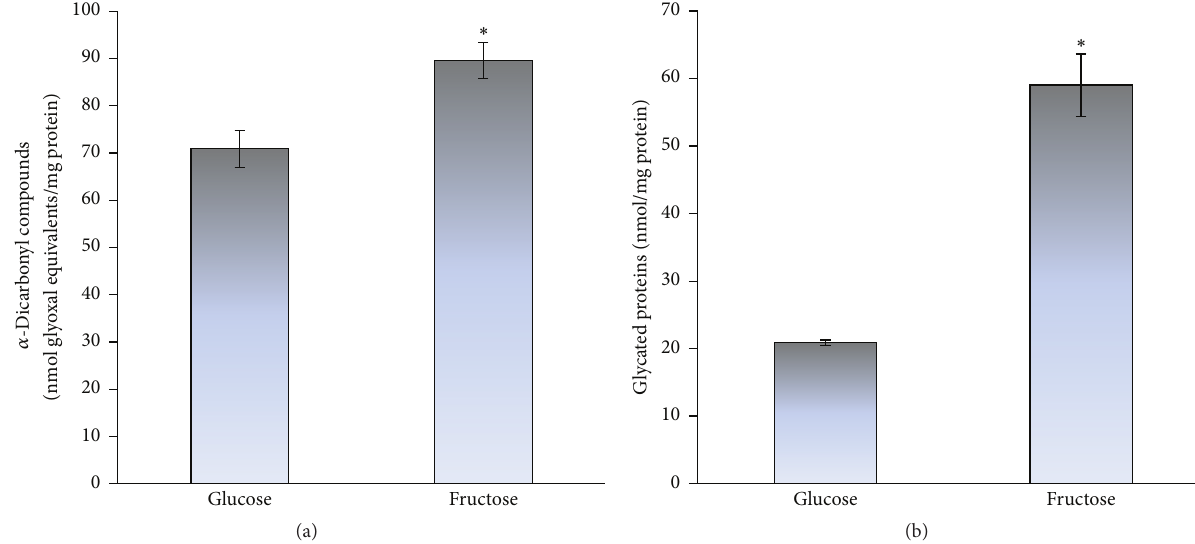
Figure 3: The level of carbonyl stress markers: 𝛼 -dicarbonyl compounds (a) and glycated proteins (b), in glucose- and fructose-grown S. cerevisiae YPH250. Results are shown as the mean ± SEM ( 𝑛 = 4 – 6 ). ∗ Significantly different from respective values for glucose with 𝑃 < 0.05